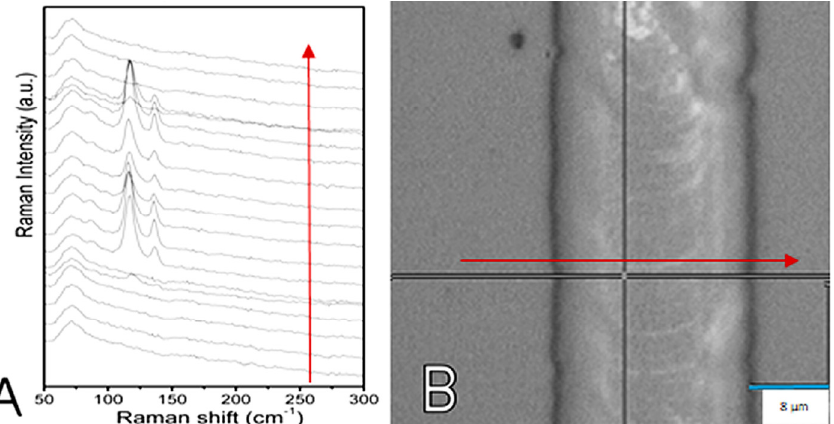
Figure 13. Micro-Raman spectra ( A ) taken across a channel waveguide ( B ) fabricated in an Er 3+ - doped Tellurite glass with 3.5 MeV N 3+ ion irradiation through a silicon mask. Length of the blue bar in ( B ) is 8 μ m. The red arrows show the direction of the Raman mapping along a line perpendicular to the waveguide ( B ) and the order of the corresponding Raman spectra ( A ). Note the appearance of two new Raman peaks in the implanted region, i.e., across the channel waveguide.